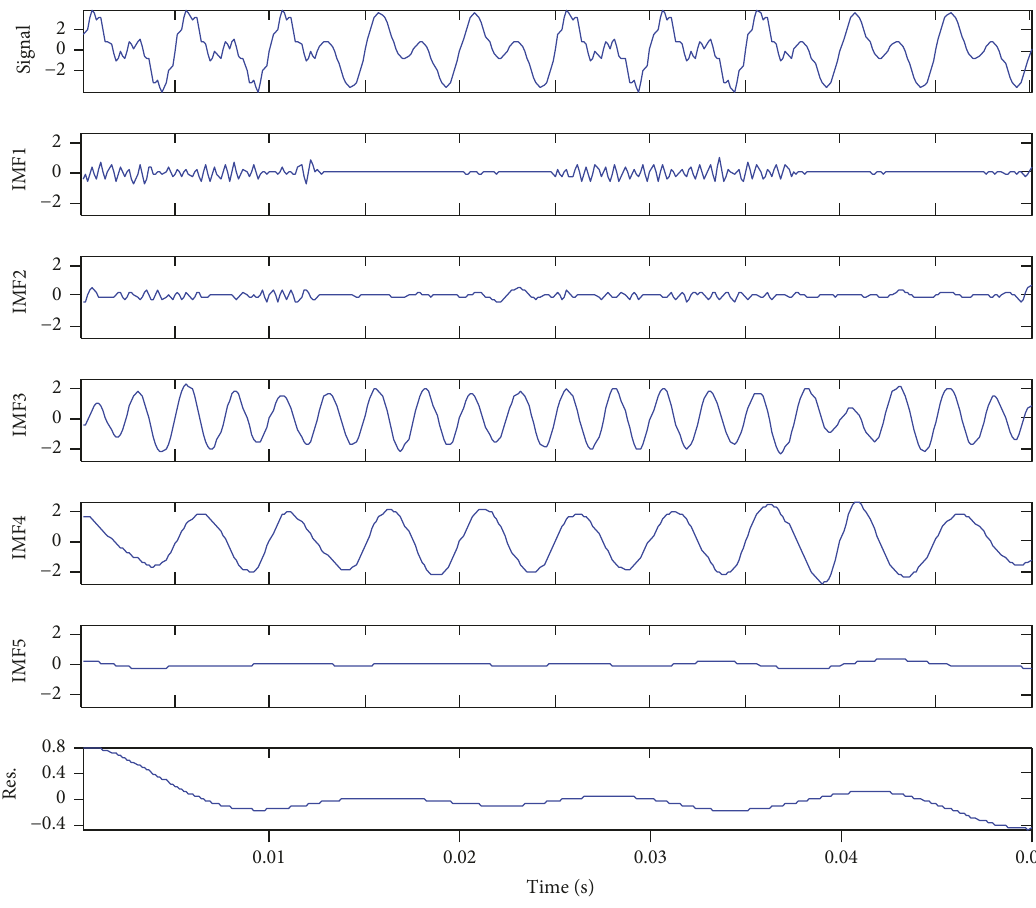
Figure 6: The decomposition results of